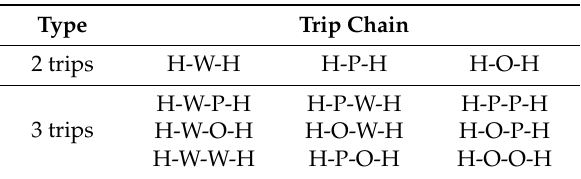
Table 1. Trip chains of PEVs.